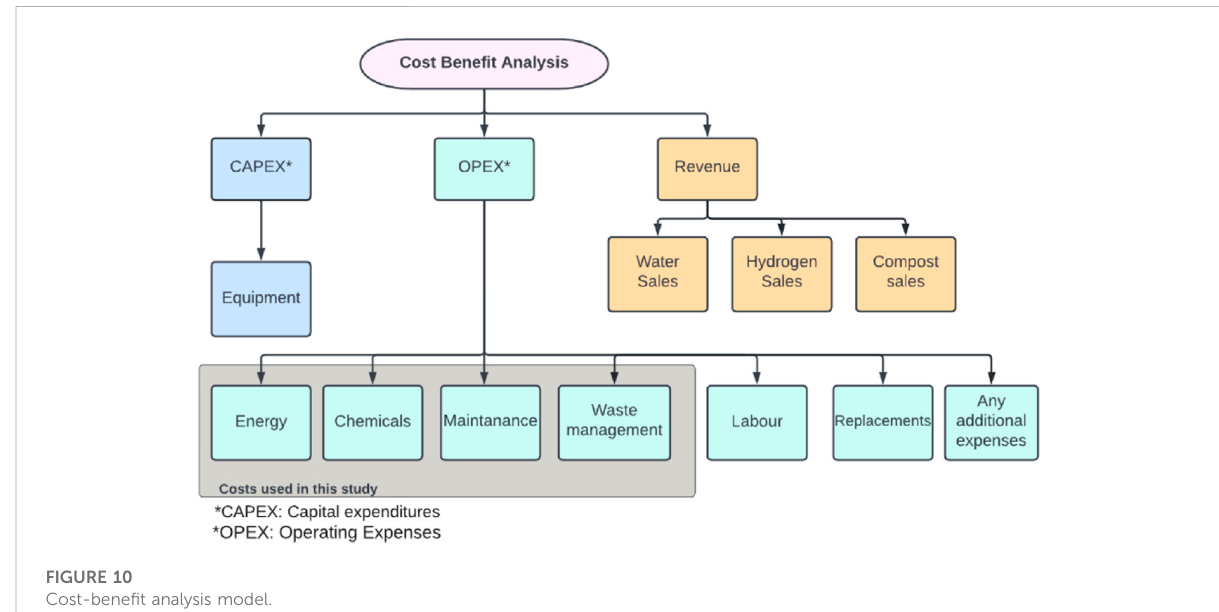
FIGURE 10 Cost-bene fi t analysis model.